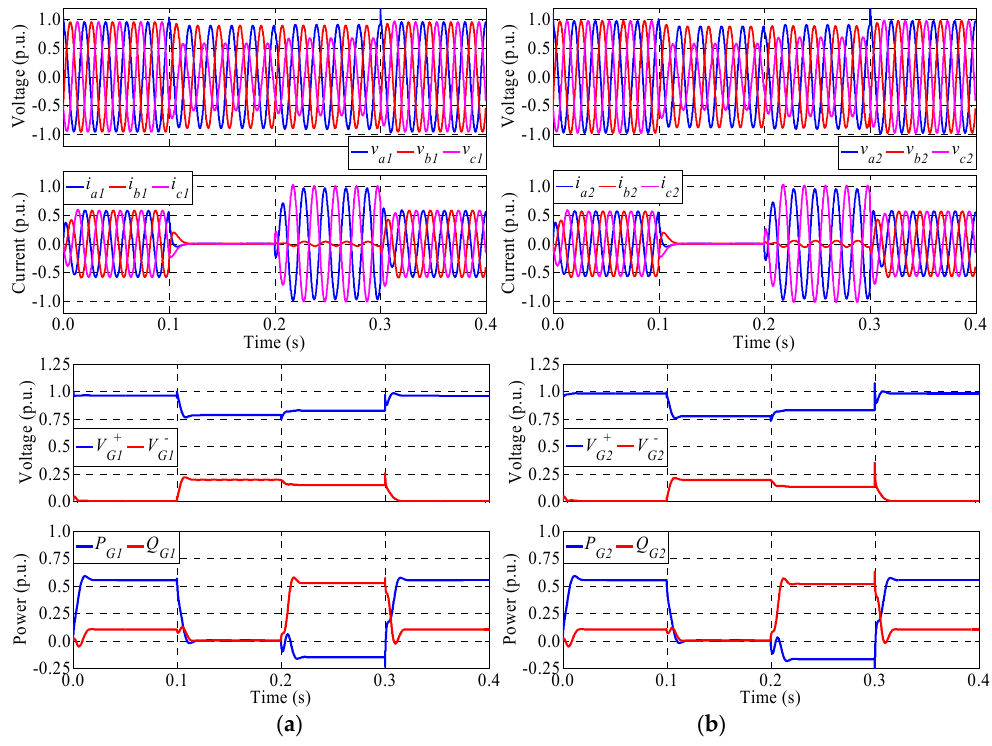
Figure 8. Main waveforms of ( a ) generator 1 and ( b ) generator 2 using the GCCS3 control scheme for type I voltage sag.